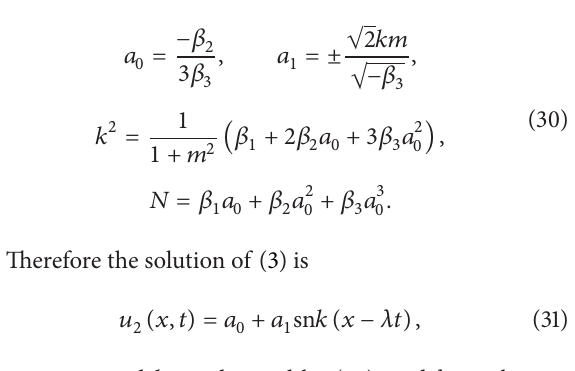
Figure 1: The solitary wave and behavior of the solutions 𝑢(𝑥,𝑡) = −1 + 2 tanh (𝑥 + 𝑡) for 0 ⩽ 𝑡 ⩽ 1 and −10 ⩽ 𝑥 ⩽ 10 .